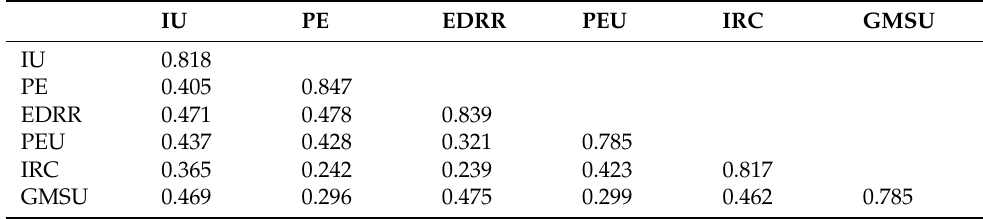
Table 4. Matrix of